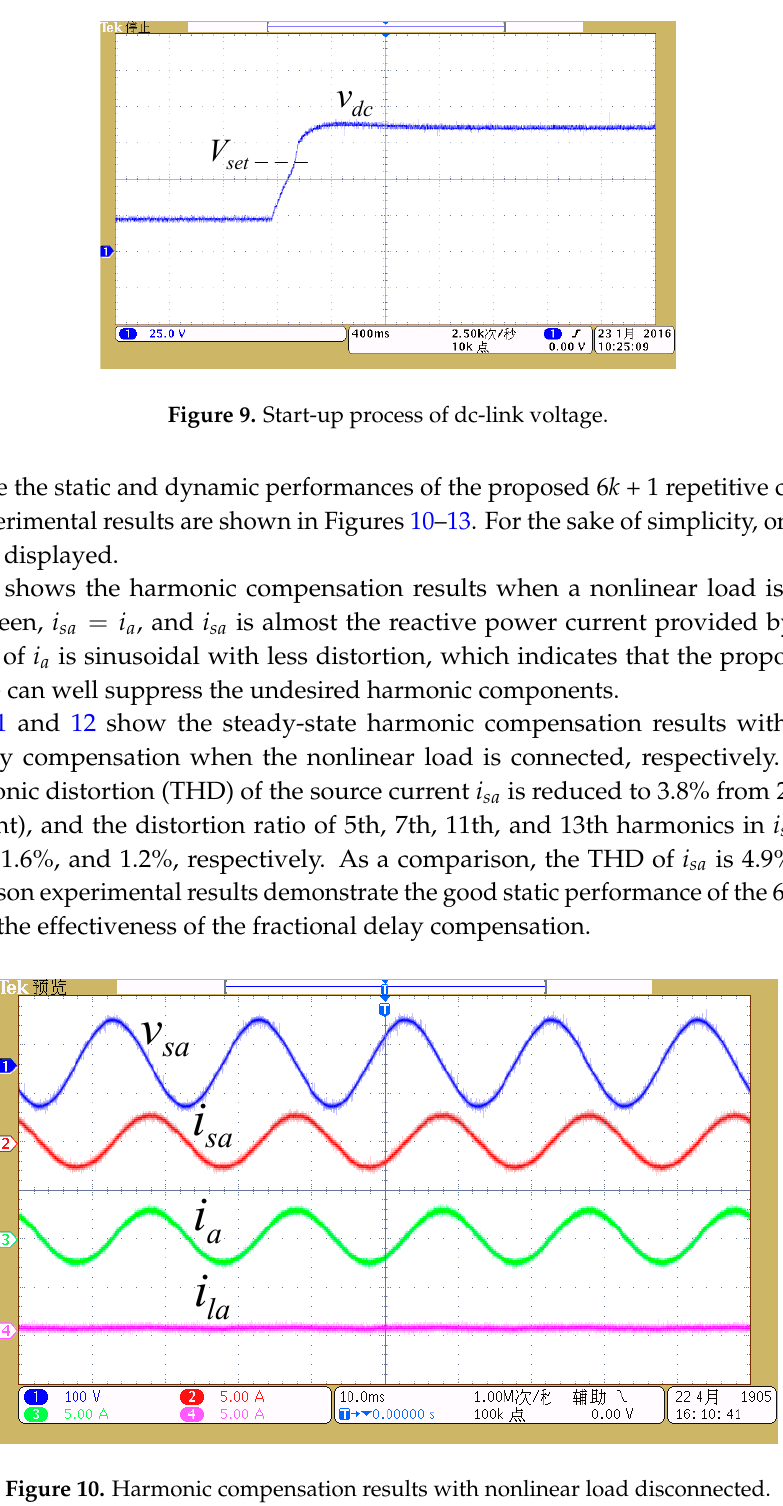
Figure 10. Harmonic compensation results with nonlinear load disconnected.